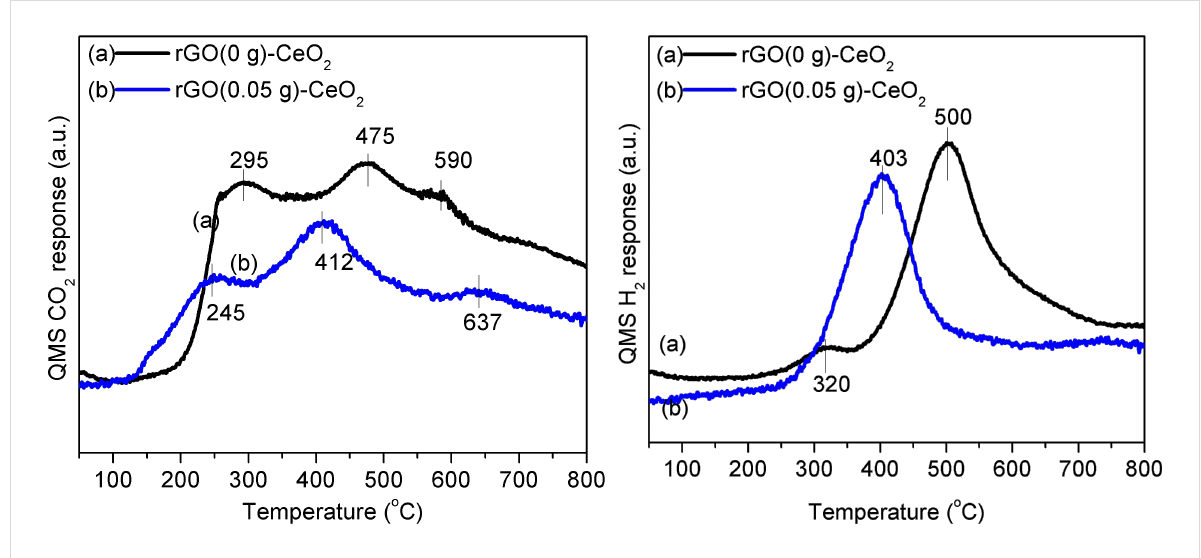
Figure 7: CO 2 (left) and H 2 (right) evolution during CO-TPR over rGO(0)–CeO 2 and rGO(0.05)–CeO 2 .